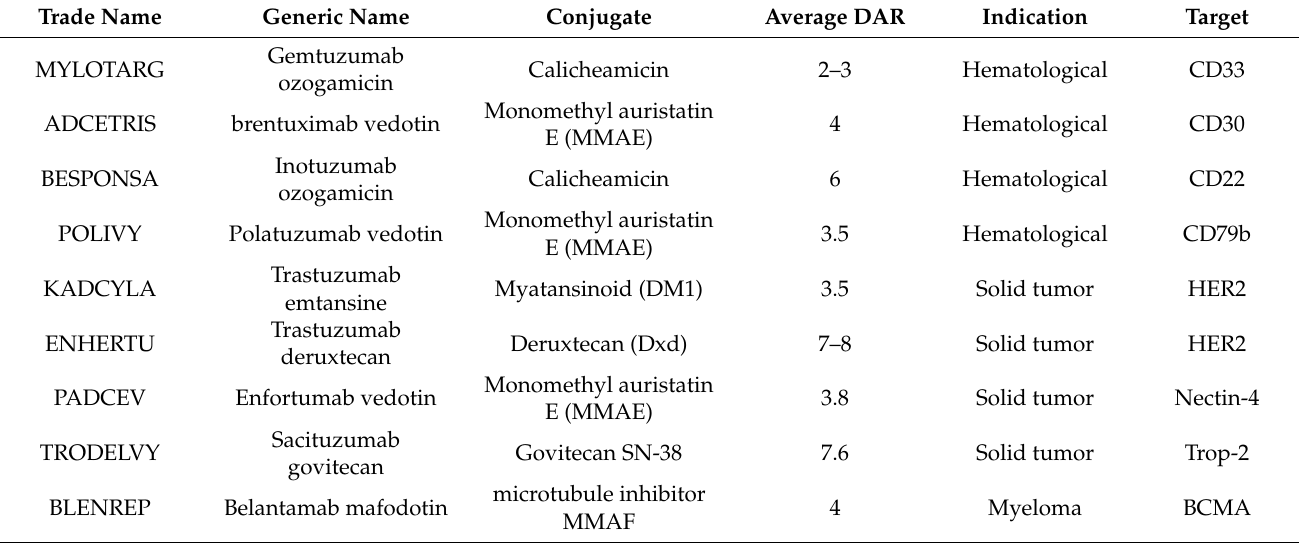
Table 1. FDA approved ADCs and their